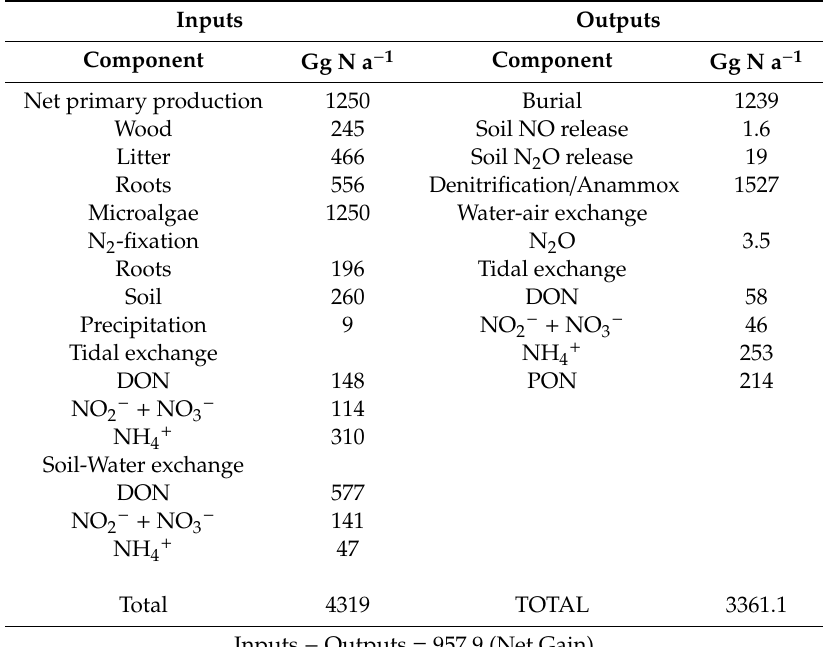
Table 6. A nitrogen mass balance of the world’s mangrove ecosystems. Units = Gg N a − 1 . Values are from Figure